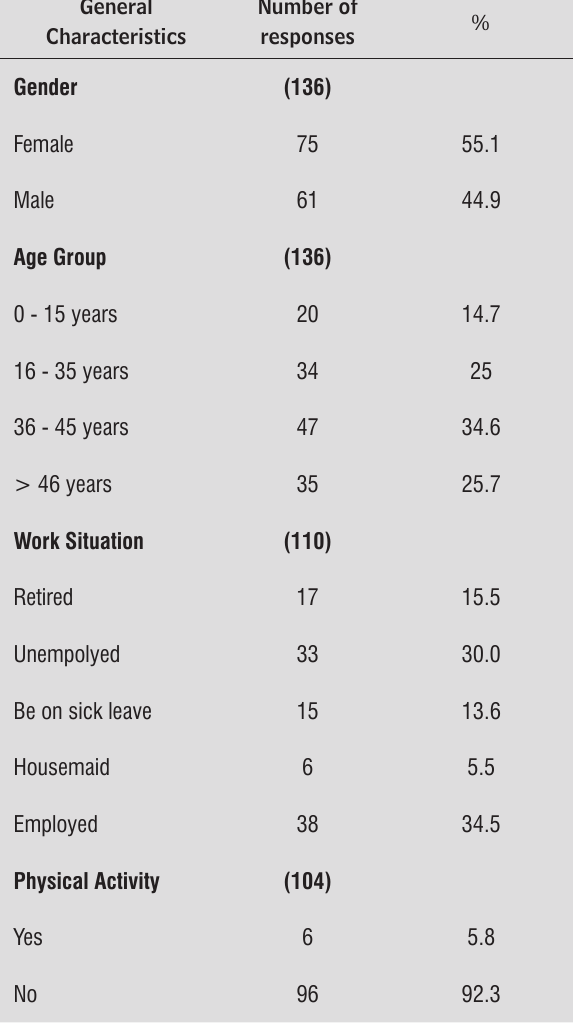
Table 1 - General Characteristics of infected users